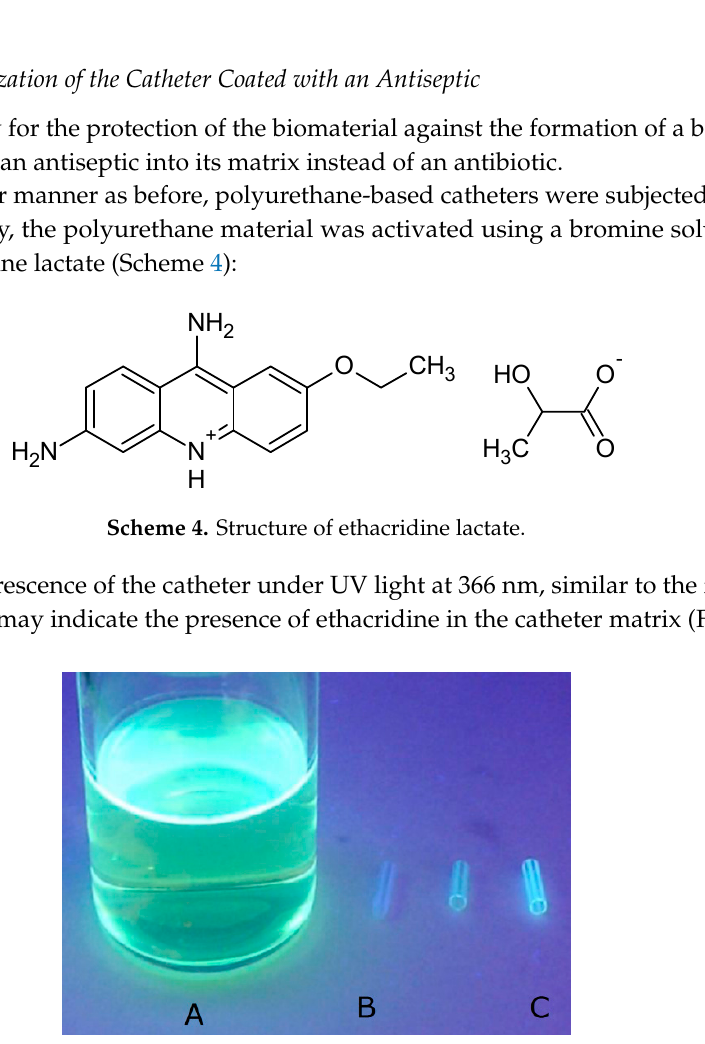
Figure 5. Ethacridine solution ( a ), the untreated catheter ( b ) and the ethacridine-treated catheter ( c ).